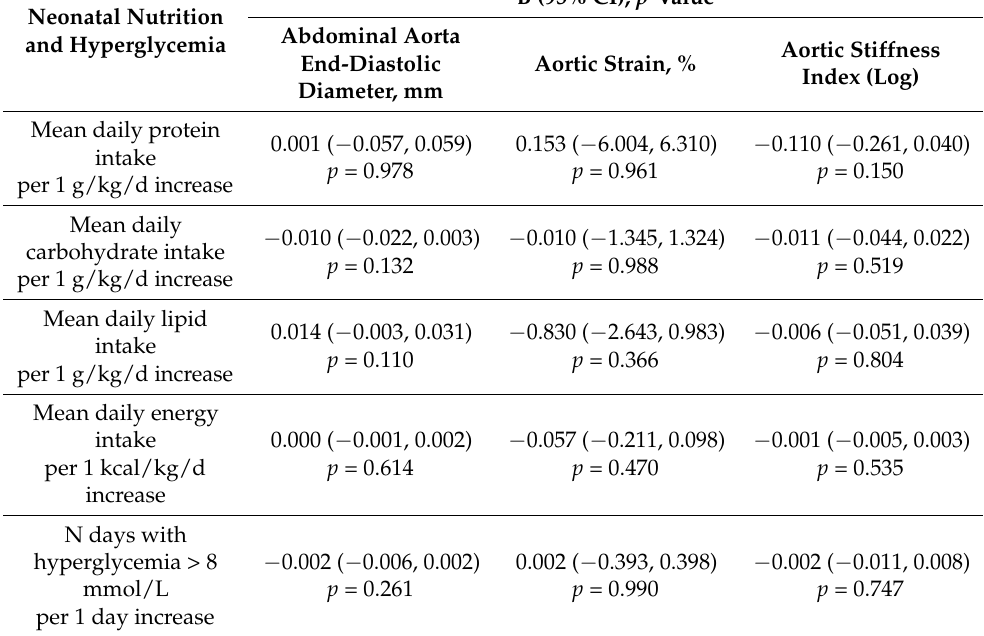
Table 7. Associations between neonatal macronutrient and energy intakes and hyperglycemia during the neonatal period with abdominal aortic diameter and stiffness at 6.5 years of age in children born extremely